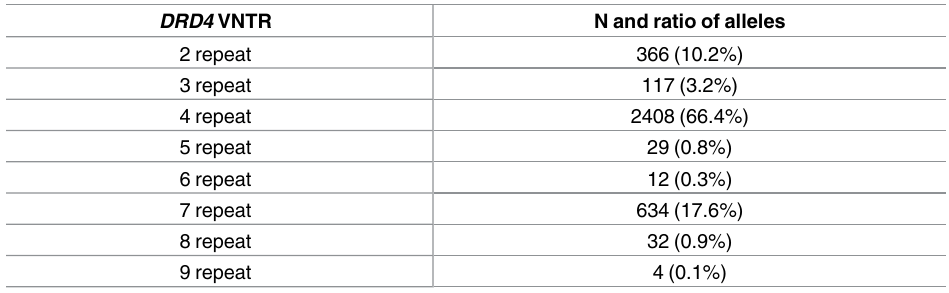
Table 1. Frequency values of DRD4 VNTR